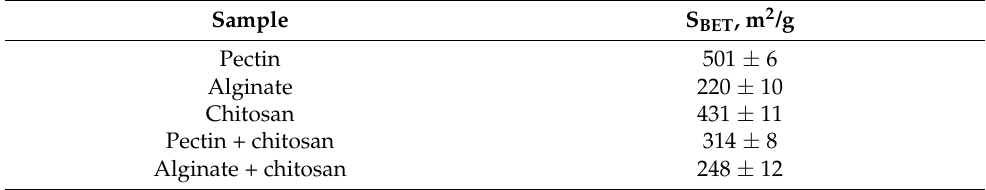
Table 1. The specific surface areas of pectin, alginate, chitosan, and their composites.